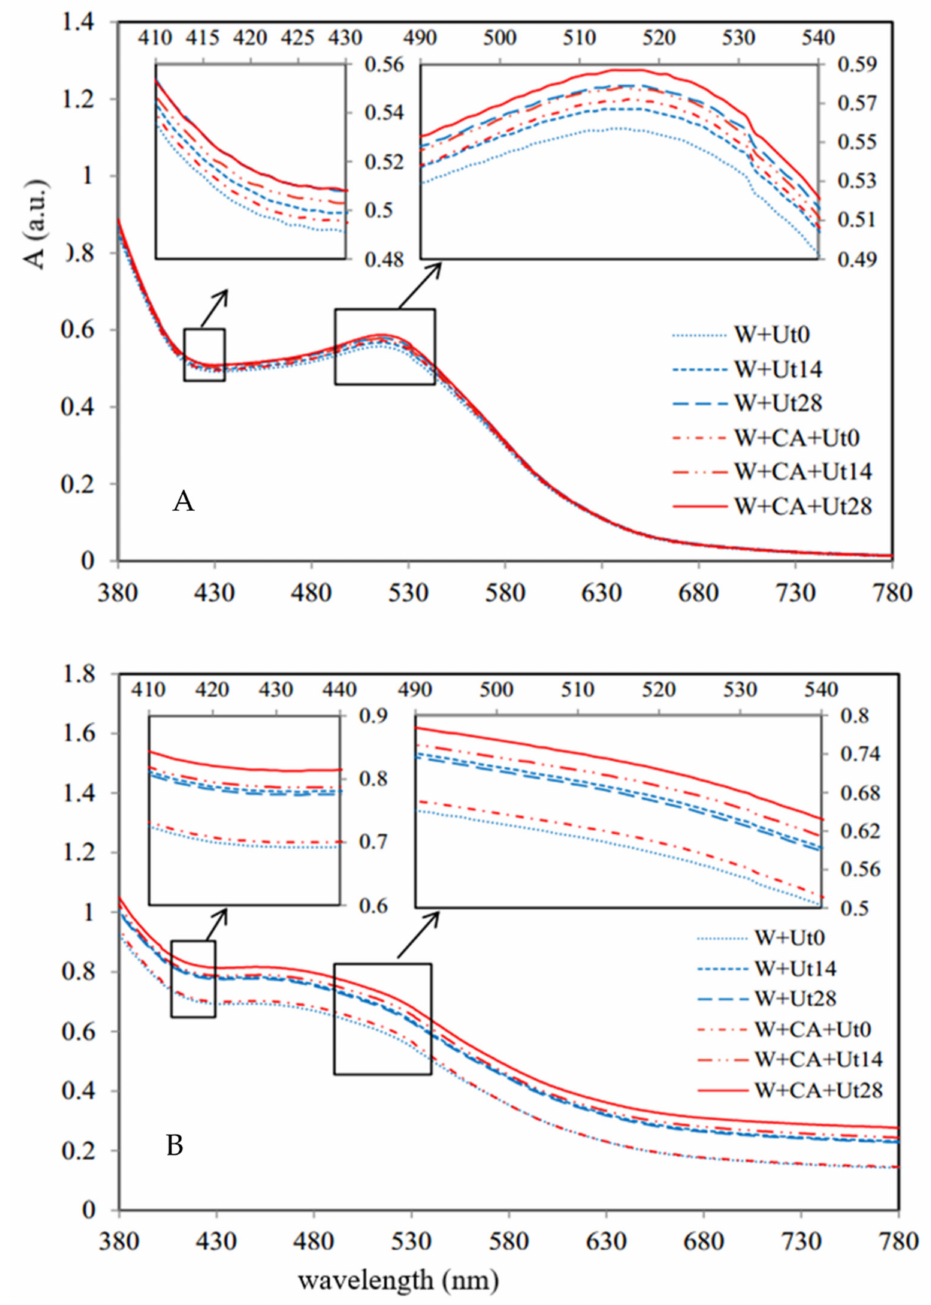
Figure 1. Visible spectra of red wine samples of W+Ut0, W+Ut14, W+Ut28, W+CA+Ut0, W+CA+Ut14, W+CA+Ut28 on the 1st ( A ) and 120th ( B ) storage